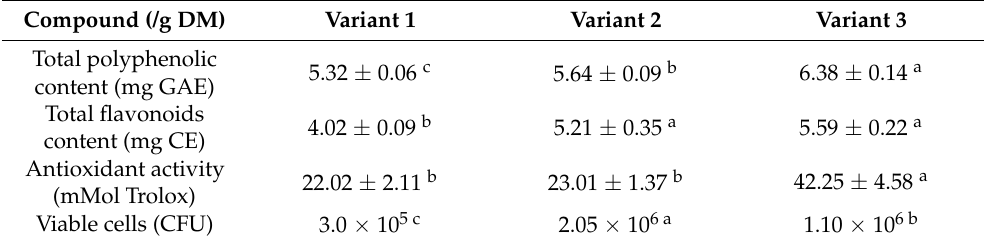
Table 3. Global phytochemical content, antioxidant activity and viable cell counts of the